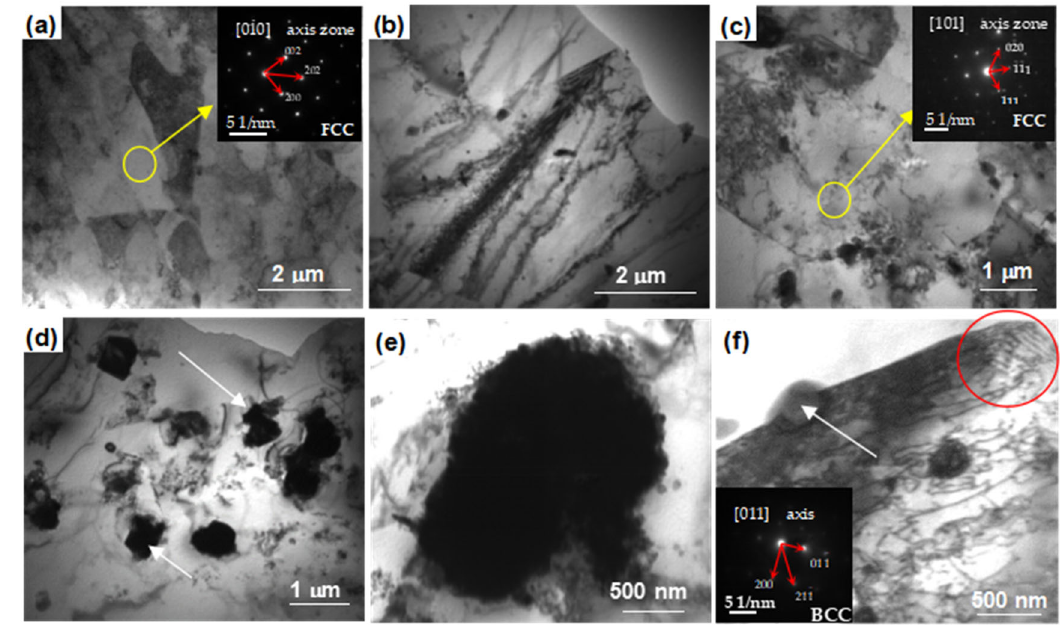
Figure 13. TEM images of 10 vol.% (AlFeNiCrCoTi0.5)p/6061Al composites: ( a ) elongated grain; ( b ) high-density dislocation band; ( c ) subgrain; ( d ) dispersive particle in the Al matrix; ( e ) dispersive particle; ( f ) dislocation in HEA.